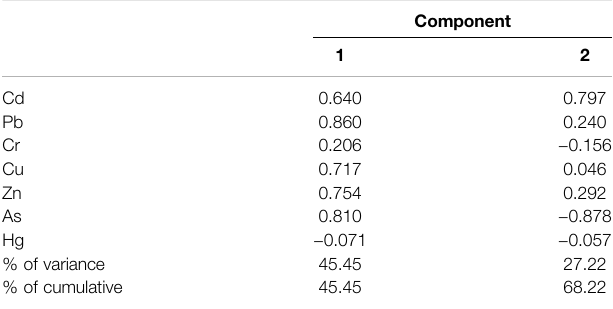
TABLE 3 | Heavy metal communality of rotated component matrix for Cd, Pb, Cr, Cu, Zn, Hg, and As of surface sediments in Daya Bay.